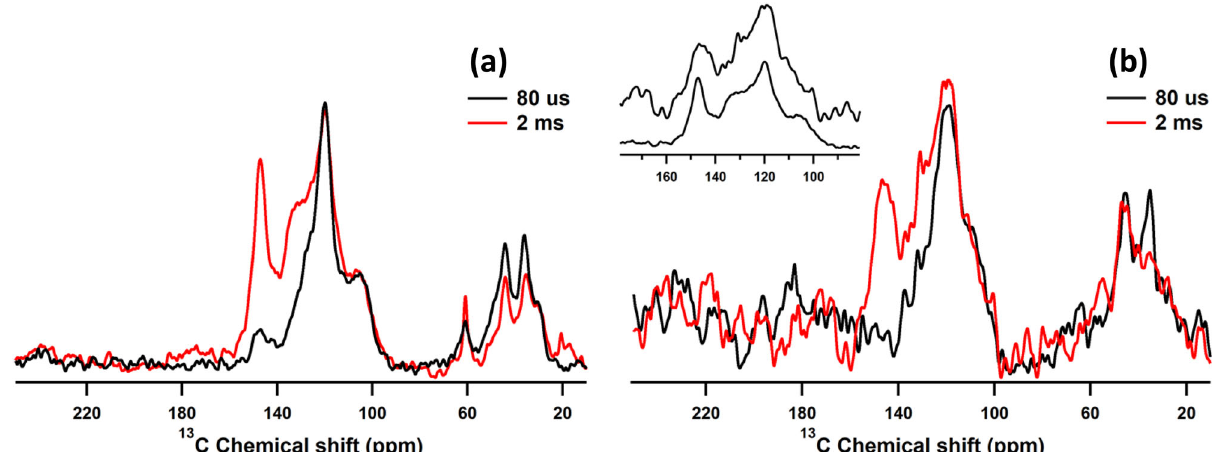
Fig. 3 | Solid-state NMR of PDA formed in absence and presence of HNTs. a Carbon-13 cross-polarization (CP) magic angle spinning NMR spectra for poly- dopamine formed in the absence of HNTs (PDA-A) after 24h of polymerization time. Spectra are shown for short (80 μ s, black) and long (2ms; red) CP contact times.Theformerexperimentshowsonlyprotonatedcarbons,wherethelatteralso